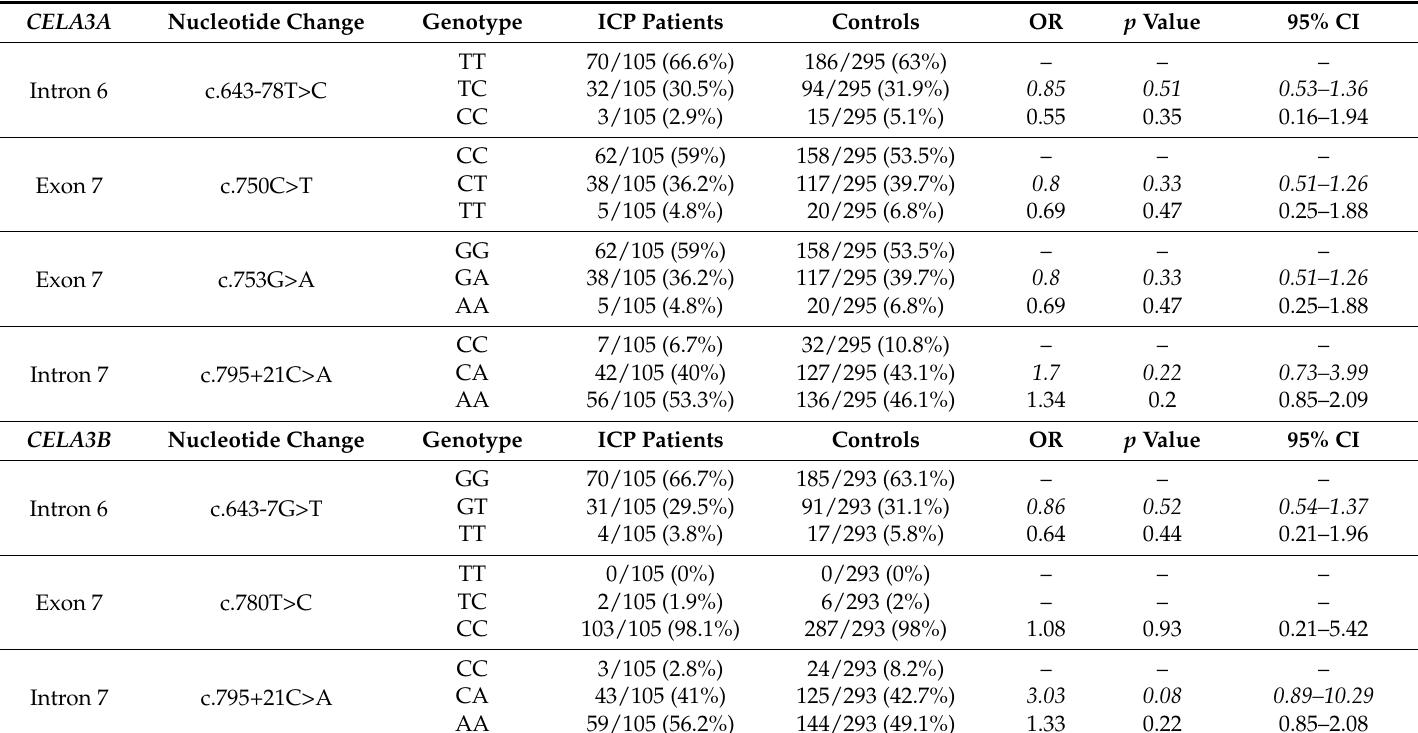
Table 6. Genotype distribution of common CELA3A and CELA3B variants in patients with idiopathic chronic pancreatitis (ICP). Results were analyzed assuming dominant (shown in italics) or recessive models of inheritance. OR, odds ratio; CI, confidence